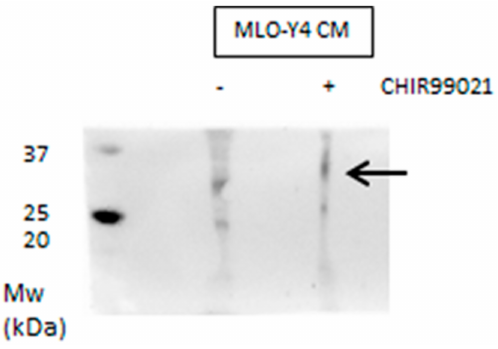
Figure 10. conditioned media from MLO-Y4 treated or not with CHIR99021100 nM for 48 h were concentrated and analyzed in SDS-PAGE. Sclerostin antibody revealed a band relative to 27–30